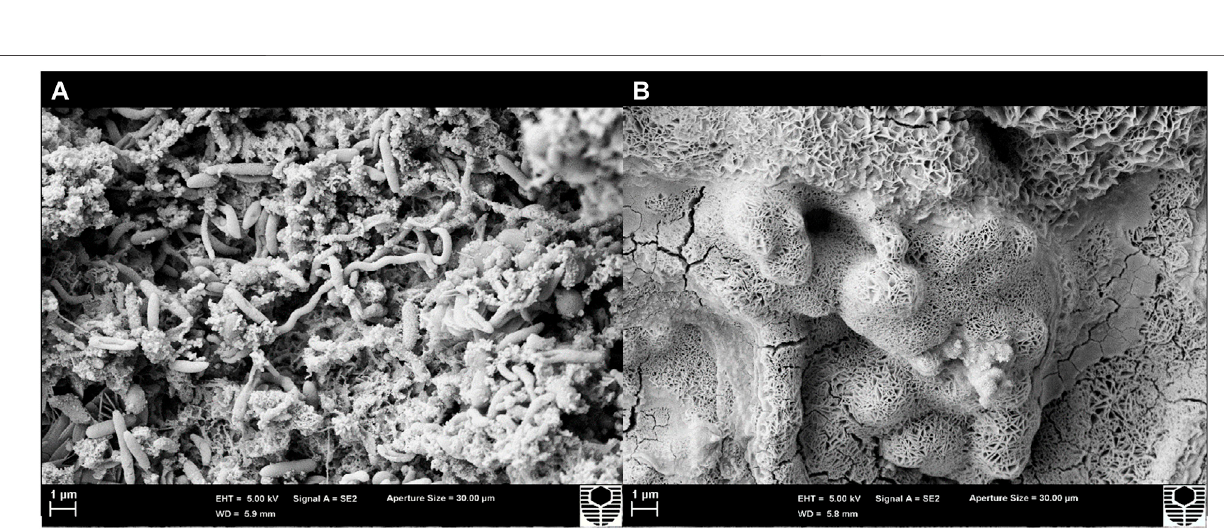
Frontiers in Bioengineering and Biotechnology |